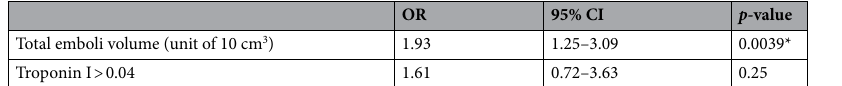
Table 4. Backward stepwise logistic regression for RV dysfunction. The Full model includes total emboli volume, chronic heart lung disease, age, gender, history of cancer, BNP, Troponin I, systolic blood pressure and respiratory rate as the predicting factors. After backward stepwise selection, the remaining factors were total emboli volume and tropoin I. BNP B-type natriuretic peptide, MPA diameter of main pulmonary artery. * The threshold for statistical significance was p <